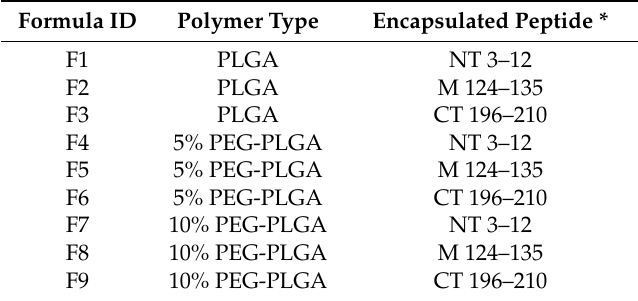
Table 1. Different formulations of peptide-loaded NPs and corresponding identifiers.